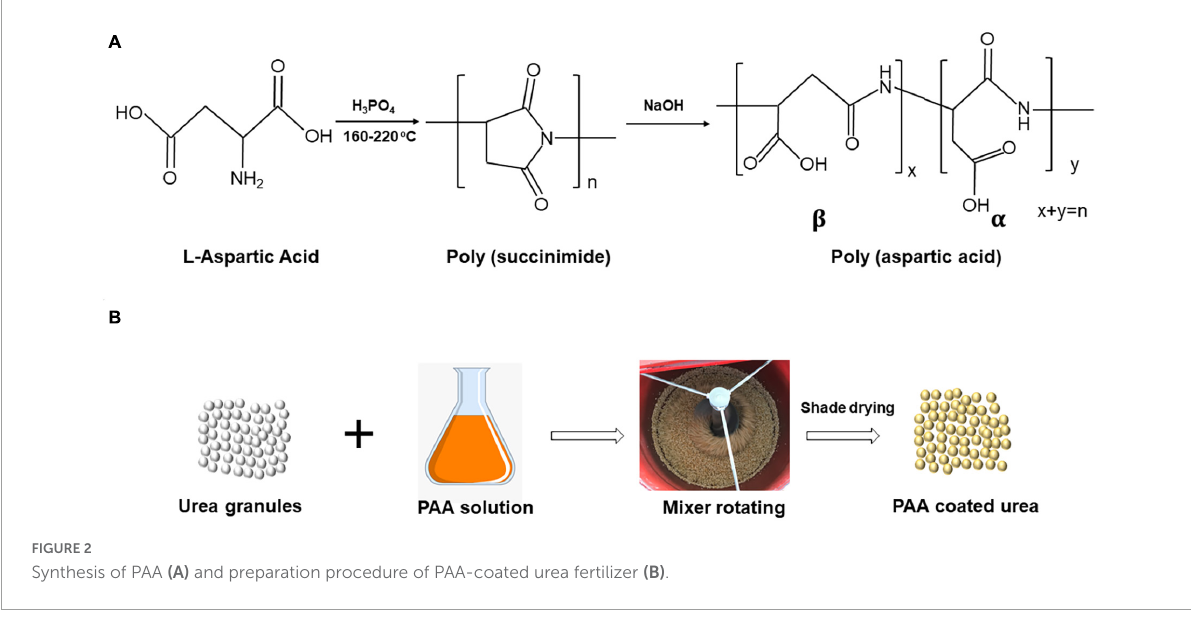
FIGURE2 Synthesis of PAA (A) and preparation procedure of PAA-coated urea fertilizer (B) .